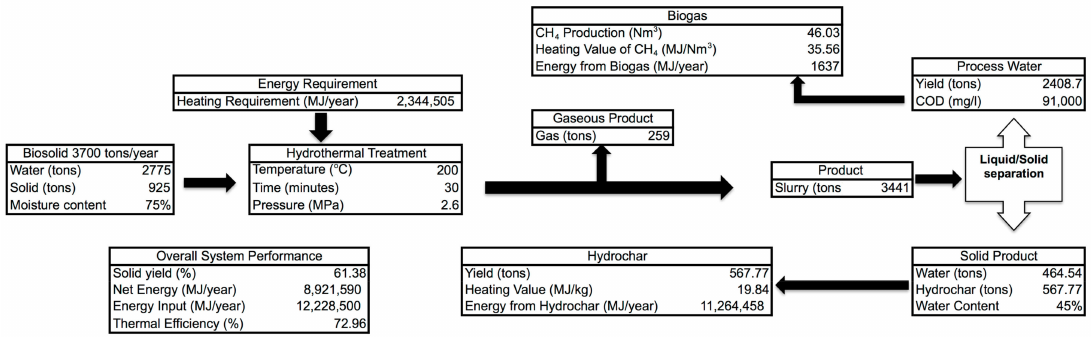
Figure 4. Mass and energy balance for hydrothermal treatment of